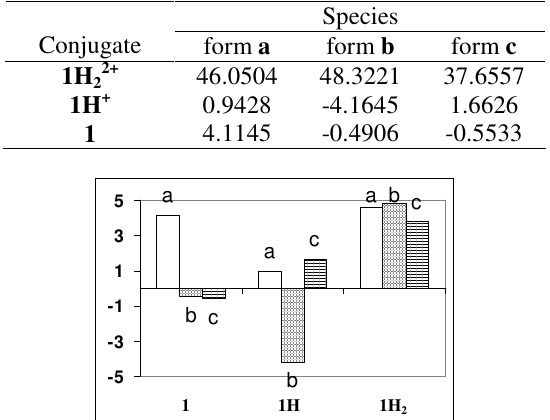
Table 1. Heats of formation, in (kJ mol -1 ) of various conjugates of 1 .